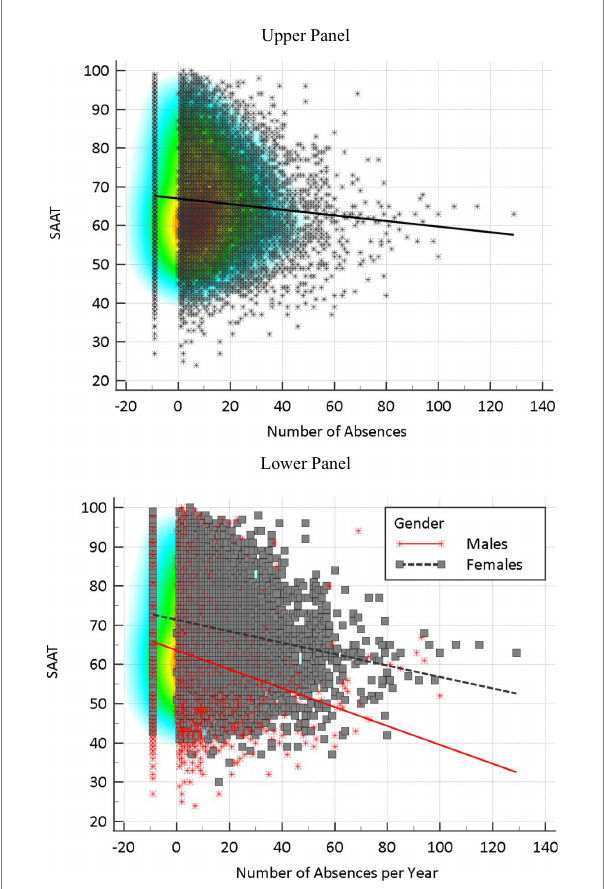
FIGURE 4 Number of absences as correlates of student achievement in high school using the SAAT measure for the full sample (upper panel) and by gender (lower